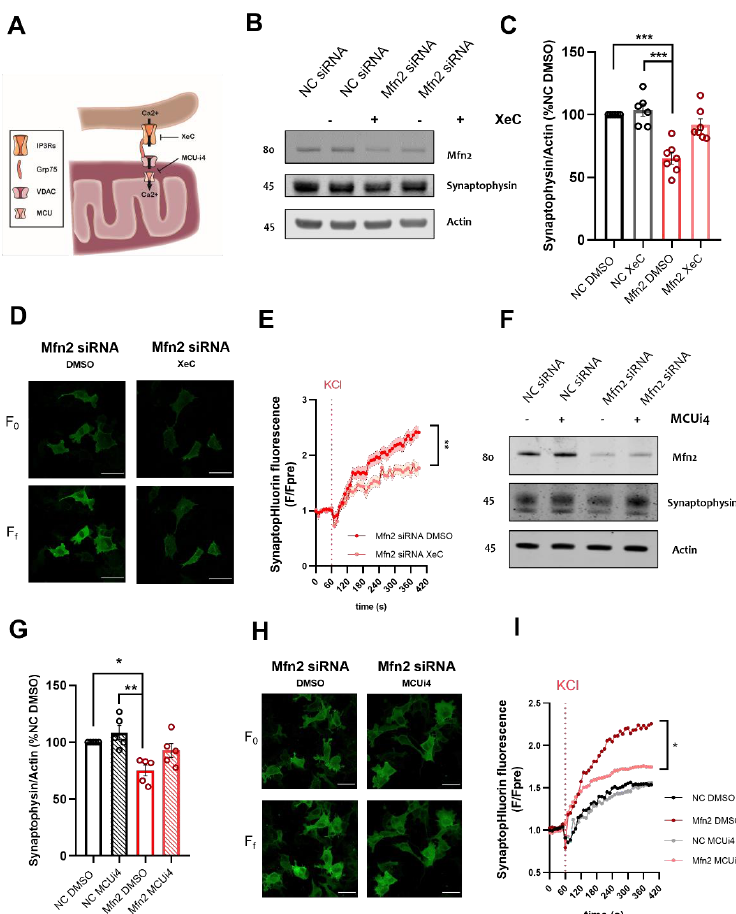
Figure 4. Inhibition of ER to mitochondria Ca 2+ shuttling abrogates Mfn2-dependent down-regulation of synaptophysin levels and increased exocytosis ( A ) Schematic representation showing mode of action of Xestospongin C (XeC) and MCUi4 at MERCS ( B ) Representative immunoblots of NC siRNA or Mfn2 siRNA SH-SY5Y cells treated or 6 h with DMSO or 1 µ M XeC. Blots were probed with antibodies against Mfn2, synaptophysin and actin, which was used as a loading control. ( C ) Bar graph shows the amounts of synaptophysin protein once standardized to actin content in each sample ( n = 5 independent cultures) ( D ) Representative confocal images of Mfn2 siRNA SH-SY5Y cells treated with DMSO or XeC 1 µ M for 6 h. Panels show initial fluorescence (F 0 ) and final fluorescence (F f ). Scale bar = 10 µ m ( E ) Graph shows normalized SypHy fluorescence over time in Mfn2 siRNA treated with DMSO or XeC, each timepoint ( F ) was normalized to average pre stimulation fluores- cence levels (F pre ). After one minute of basal recording, cells were depolarized with 50 mM KCl ( n = 24–27 cells from four independent cultures). Ratiometric difference between F f /F 0 was shown to be significant p ≤ 0.01. ( F ) Representative immunoblots of NC siRNA or Mfn2 siRNA SH- SY5Y cells treated for 6h with DMSO or 1 µ M MCUi4. Blots were probed with antibodies against Mfn2, synaptophysin and actin which was used as a loading control. ( G ) Bar graph shows the amounts of synaptophysin protein once standardized to actin content in each sample ( n = 5 in- dependent cultures). ( H ) Representative confocal images of Mfn2 siRNA SH-SY5Y cells treated with DMSO or MCUi41 µ M for 6 h. Panels show initial fluorescence (F 0 ) and final fluorescence (F f ). Scale bar = 10 µ m I) Graph shows normalized SypHy fluorescence over time in NC and Mfn2 siRNA treated with DMSO or MCUi4, each timepoint ( F ) was normalized to average pre stimulation fluorescence levels (F pre ). After one minute of basal recording, cells were depolar- ized with 50 mM KCl ( n = 16–19 cells from 4 independent cultures). Ratiometric difference between F f /F 0 was shown to be significant p ≤ 0.05 between Mfn2 DMSO and Mfn2 MCUi4. * p ≤ 0.05, ** p ≤ 0.01, *** p ≤ 0.001. Data shown as mean ±